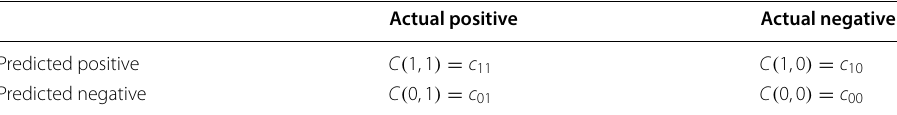
Table 2 Cost matrix Actual positive Actual negative Predicted positive C ( 1,1 ) = c 11 C ( 1,0 ) = c 10 Predicted negative C ( 0,1 ) = c 01 C ( 0,0 ) = c